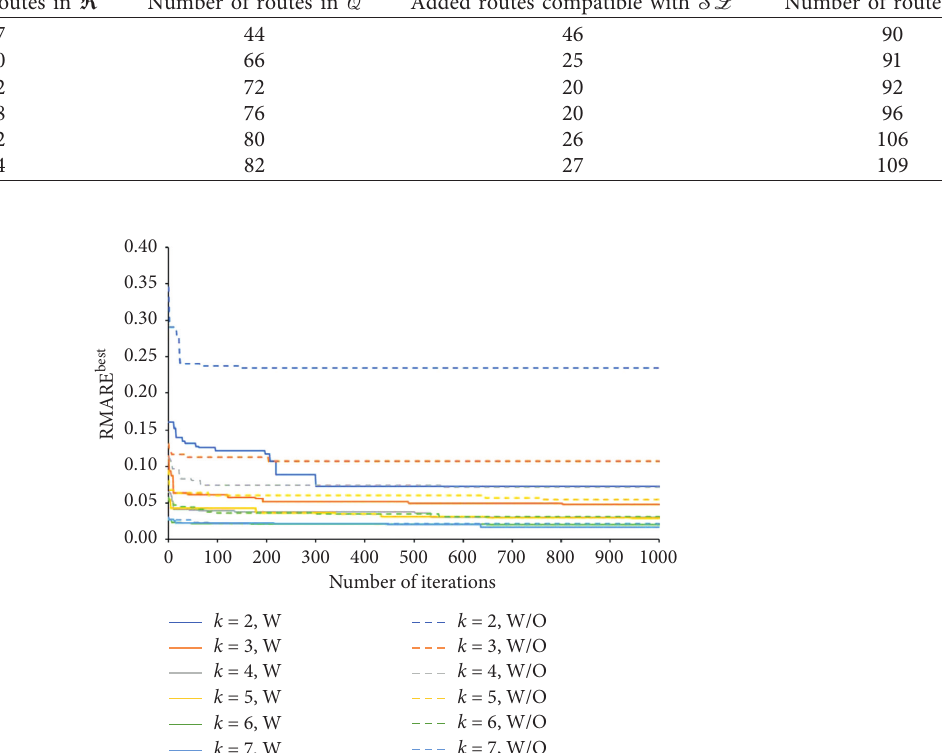
Figure 7: Evolution of the error RMARE best with the number of iterations made, considering different values of k with (W) or without (W/ O) the proposed model. Table 5: Number of routes that appear with the application of the proposed algorithm according to the F Threshold flow, F